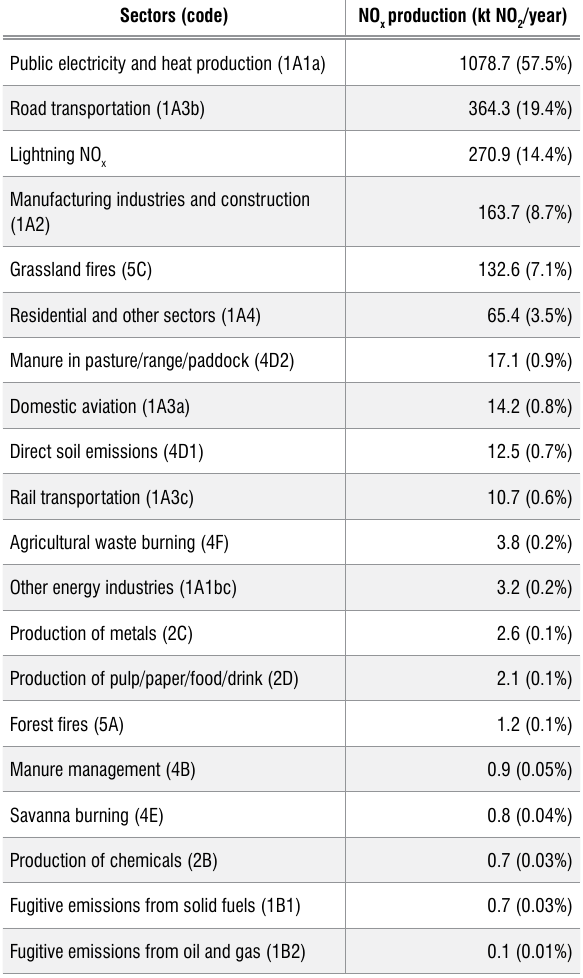
emission from EDGAR v4.2 and LNO Table 4: NO 2 over South Africa